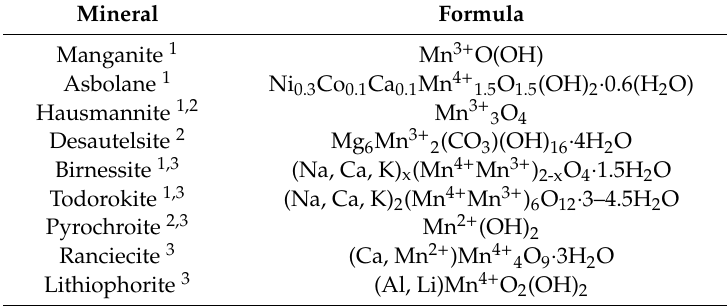
Table 2. Stoichiometric formulae of manganese oxides and oxy-hydroxides identified in di ff erent pit lakes in